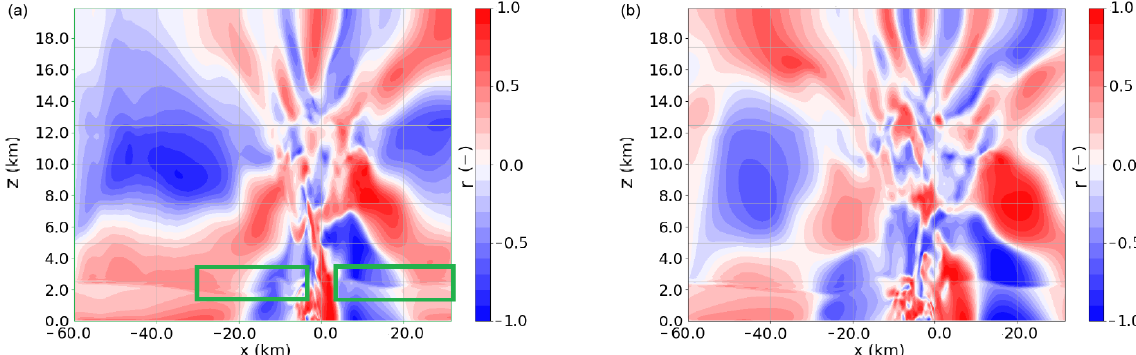
Figure 7. Correlation structure between w loc and u avg obtained from the ensemble sensitivity analysis; (a) t = 30min; (b) t = 35min. One can see a gravity wave crest at z i ≈ 2500m, propagating from x = 4km to x = 9km. With positive vertical velocity perturbations and inbound/converging u winds upon this crest, enhanced forcing for convective initiation ( x = 4km, z = 3km, t = 30min, X in Fig. 4b) is correlated with our target variable.